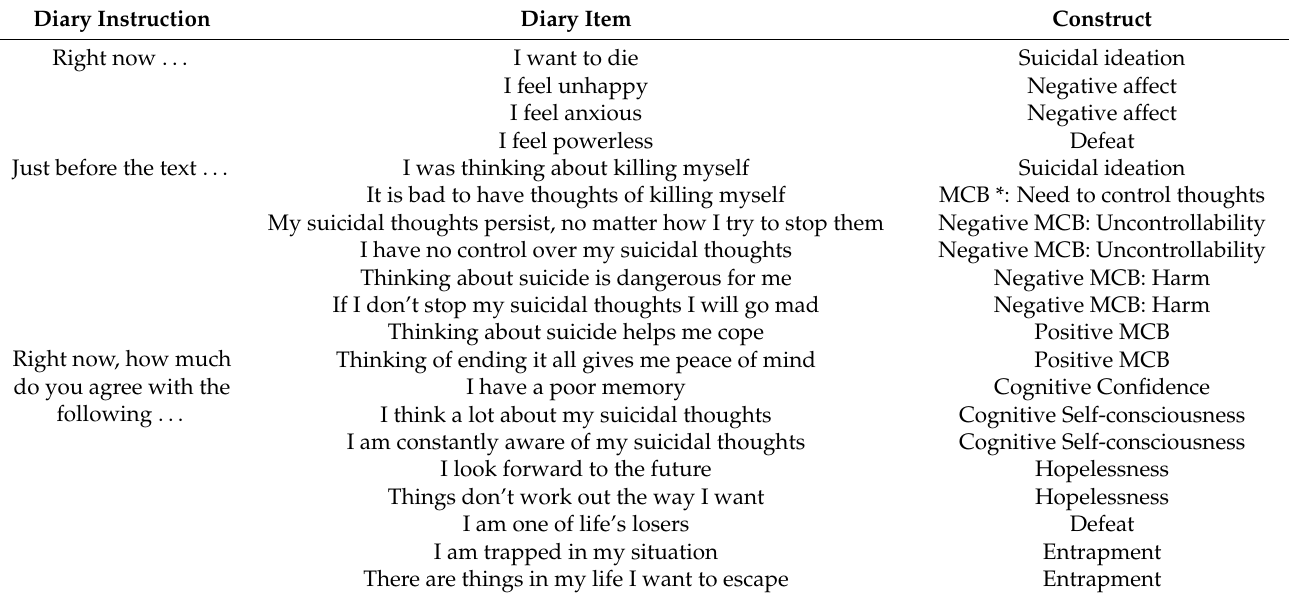
Table 2. ESM diary items and related